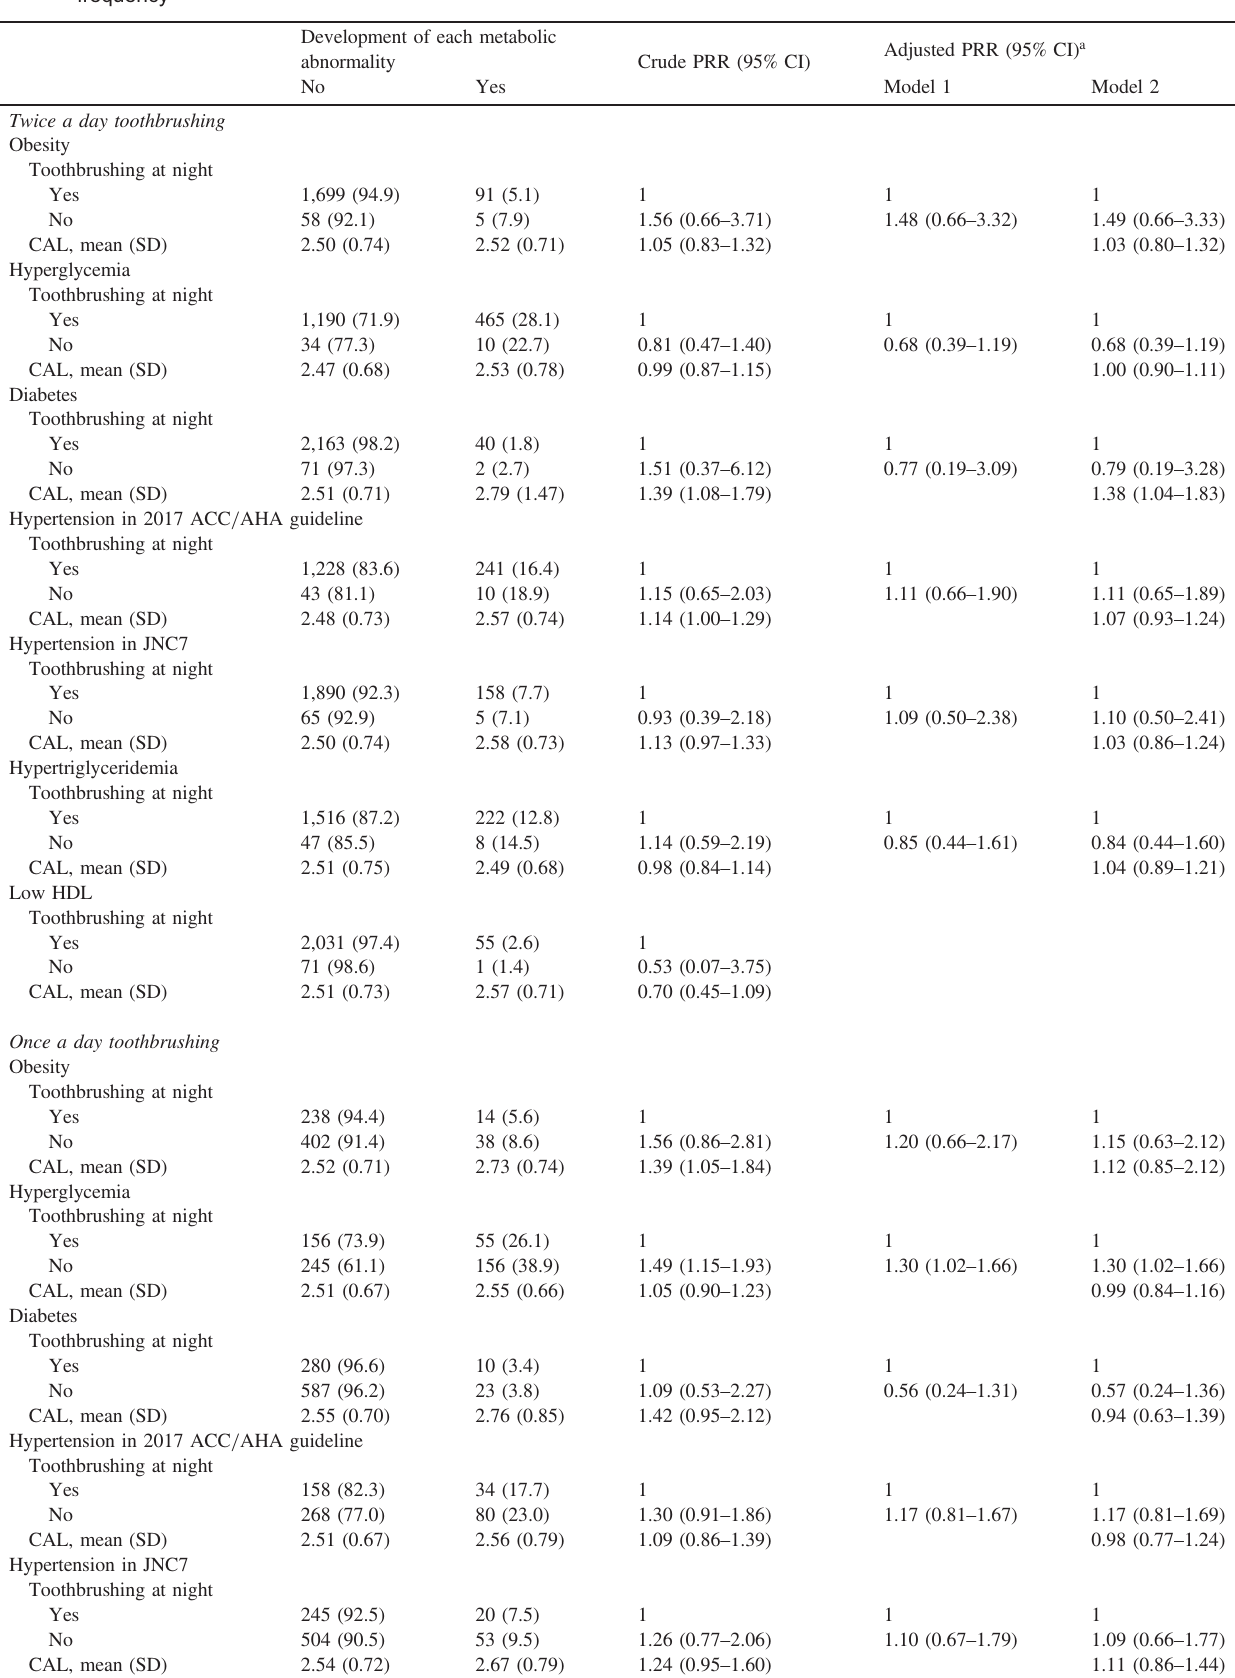
Table 7. Association between toothbrushing at night and the development of each metabolic abnormality based on toothbrushing